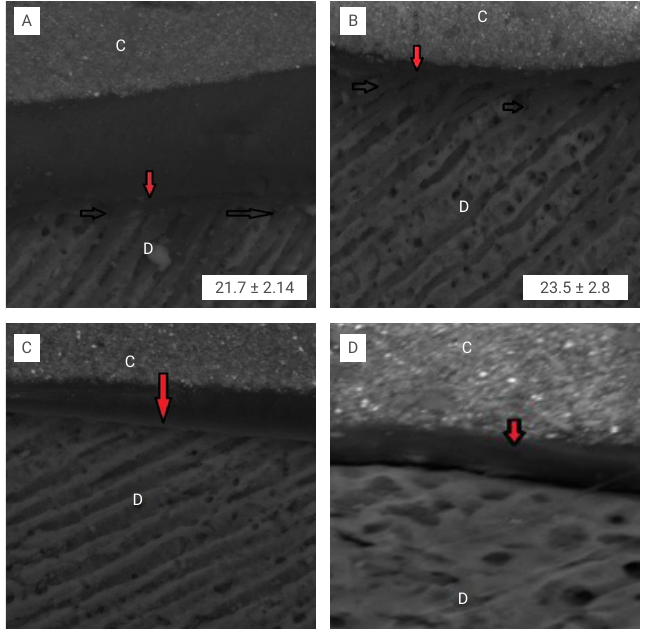
Figure 2. SEM image 3000X showing tooth restoration interface after thermocycling, (A) Scotchbond Universal etch-and-rinse mode; (B) All Bond Universal etch-and-rinse mode; (C) Scotchbond Universal self-etch mode; (D) All Bond Universal self-etch mode; (D) dentin; (C) composite; Red arrows marking the hybrid layer; White arrows marking the resin tags, rectangle: mean length(µm) of resin tags ± standard